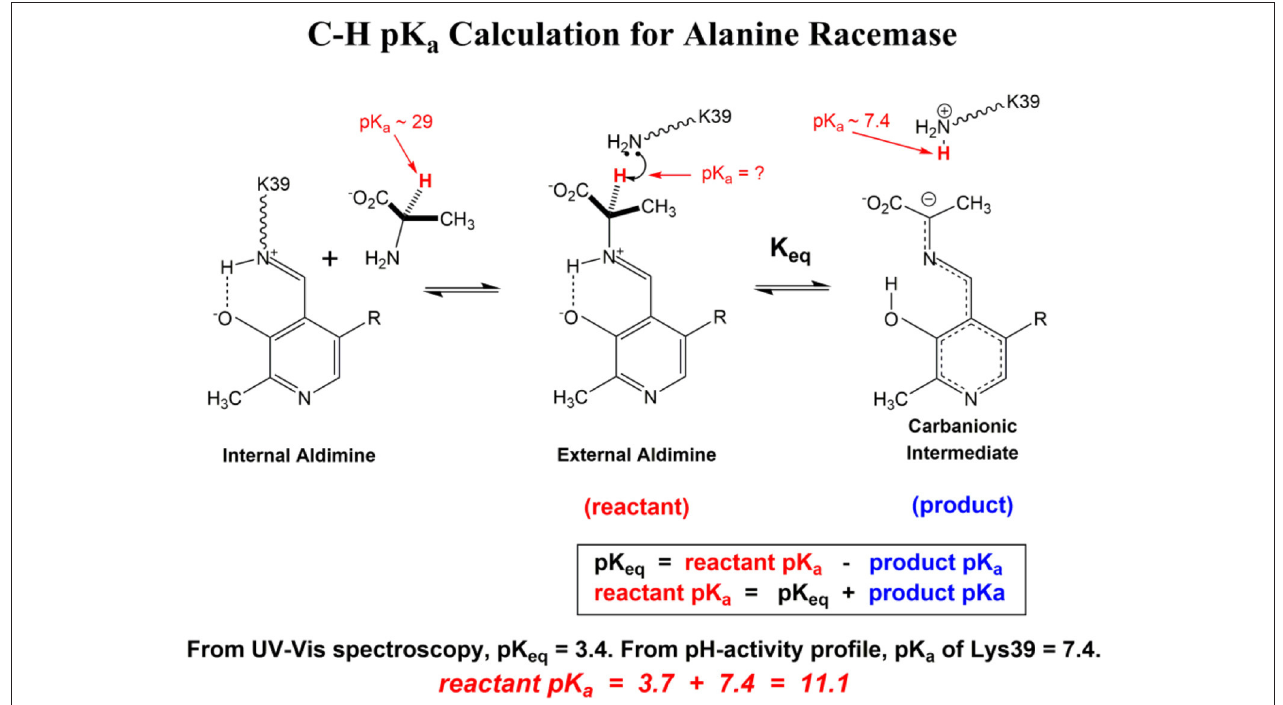
SCHEME 1 | C-H pK calculation for Alanine